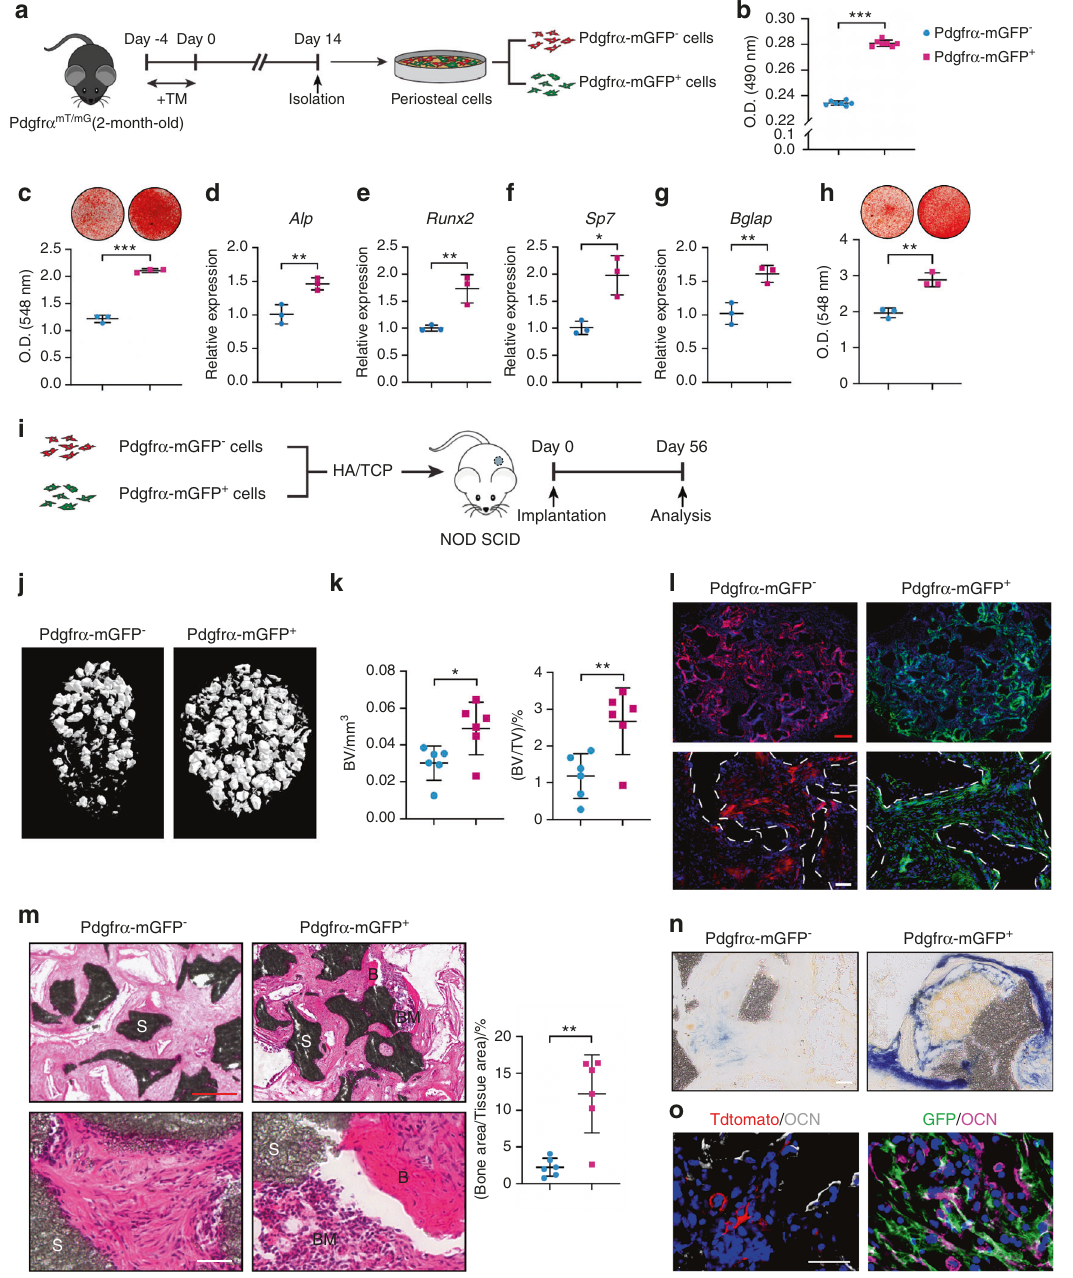
Fig. 5 Mouse PDGFR α reporter + periosteal progenitors have high osteogenic potential. a Schematic of experiments in which PDGFR α reporter − CD31 − CD45 − Ter119 − and PDGFR α reporter + CD31 − CD45 − Ter119 − periosteal cells were derived by FACS from PDGFR α mT/mG hindlimbs (male, aged 2 mo). b Cell proliferation among PDGFR α reporter − and PDGFR α reporter + periosteal cells determined by MTS assays at 72 h. c Osteogenic differentiation of PDGFR α reporter − / + periosteal cells at 16 d determined by Alizarin Red (AR) staining and quanti fi cation. Expression of the osteogenic genes, including ( d ) alkaline phosphatase ( Alp ), ( e ) runt-related transcription factor 2 ( Runx2 ), ( f ) Osterix ( Sp7 ), and ( g ) osteocalcin ( Bglap ), in PDGFR α reporter − / + periosteal cells after 7 d of differentiation. h Osteogenic differentiation of freshly isolated PDGFR α reporter − / + periosteal cells at 14 d determined by Alizarin Red (AR) staining and quanti fi cation. i Schematic of ossicle assay. PDGFR α reporter − or reporter + cells (3 × 10 6 ) were subcutaneously implanted into NOD SCID mice using an HA/ β -TCP carrier and harvested after 8 weeks. j Representative micro-CT reconstructions of the implants. k Quantitative analysis of micro-CT images of PDGFR α reporter − / + periosteal cells. The analysis included the bone volume (BV) and fractional bone volume (BV/TV). l Persistence of PDGFR α reporter + and PDGFR α reporter − periosteal cells. PDGFR α reporter − cells appeared red, and PDGFR α reporter + cells appeared green. Nuclei, DAPI (4 ′ ,6-diamidino-2- phenylindole, blue). The white dashed lines demarcate the edges of the scaffold. m Representative histologic appearance determined by H&E, including low-magni fi cation (above left) and high-magni fi cation (below left) images, and quanti fi cation of the bone area/tissue area (right). n Representative ALP staining. o OCN immunohistochemistry. Positive immunohistochemistry is shown by purple or white. PDGFR α reporter − cells appeared red (Tdtomato + ), and PDGFR α reporter + cells appeared green (GFP + ). Red scale bars: 500 μ m; White scale bars: 50 μ m. B bone, BM bone marrow, S scaffold. The dot plots represent an individual sample or animal, and the whisker plots indicate the mean and one-SD values. In vitro experiments were performed in biological and experimental triplicates ( a – h ). For subcutaneous implantation, n = 6 animals per group ( i – o ). * P < 0.05, ** P < 0.01 and *** P < 0.001, as assessed by two-tailed Student ’ s t